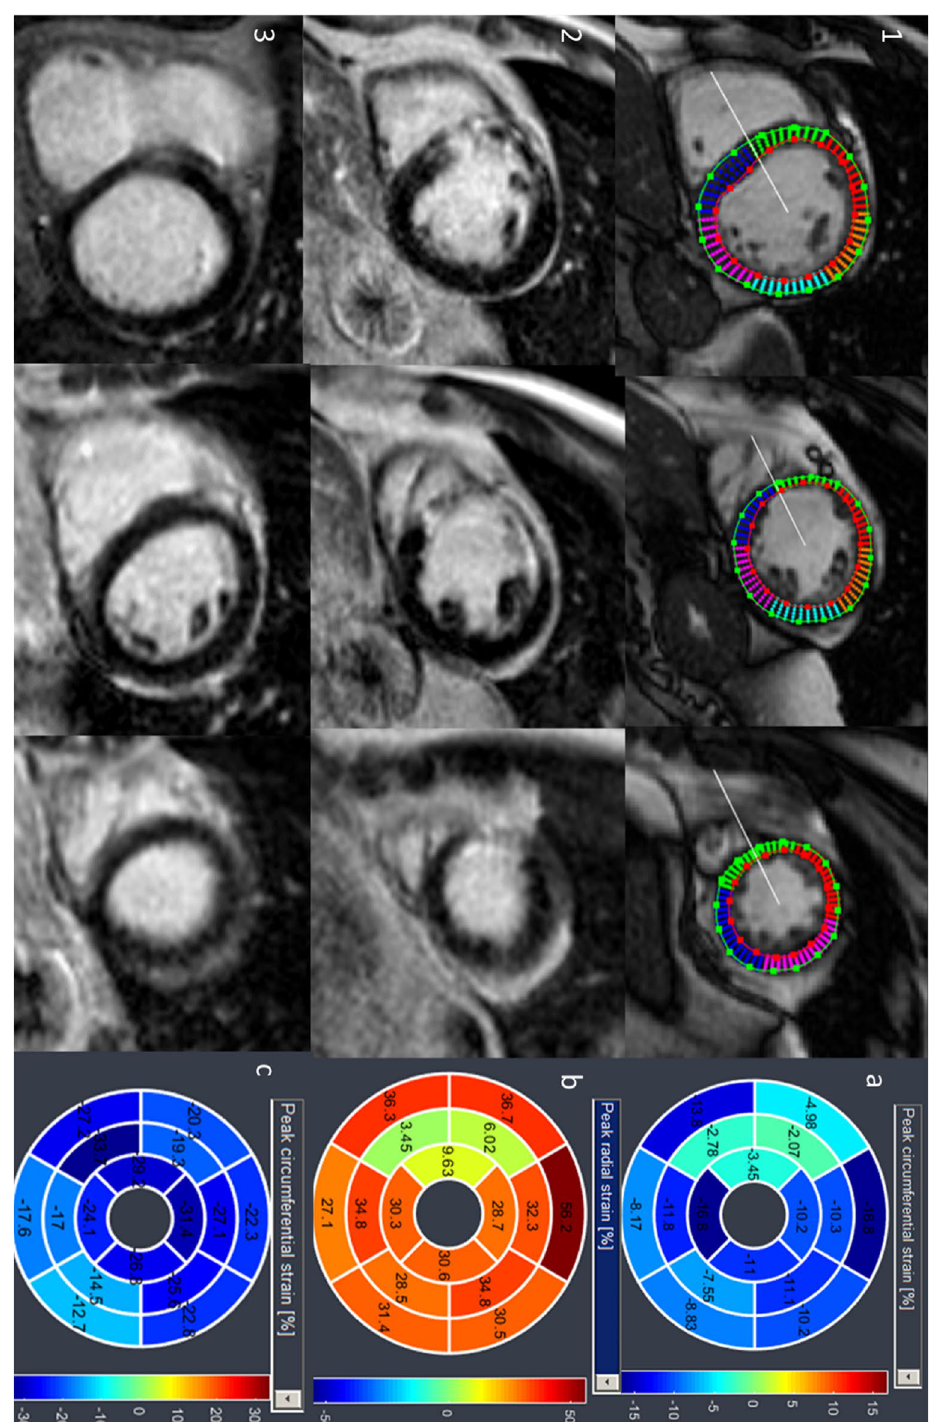
Figure 1. Basal, midventricular and apical section of cine short axis with tracked myocardial borders for segmental circumferential strain calculation (1) and LGE (2) in the same patient with RIVA infarction (segment 2, 8, 9, 15). Based on the deformation of tracked myocardial borders, polar plot maps of calculated segmental circumferential strain ( a ) and segmental radial strain ( b ) are depicted. Subendocardial infarction in segment 2 shows no segmental radial strain impairement. Basal, midventricular and apical LGE sections and circumferential strain values of a healthy control (3, c